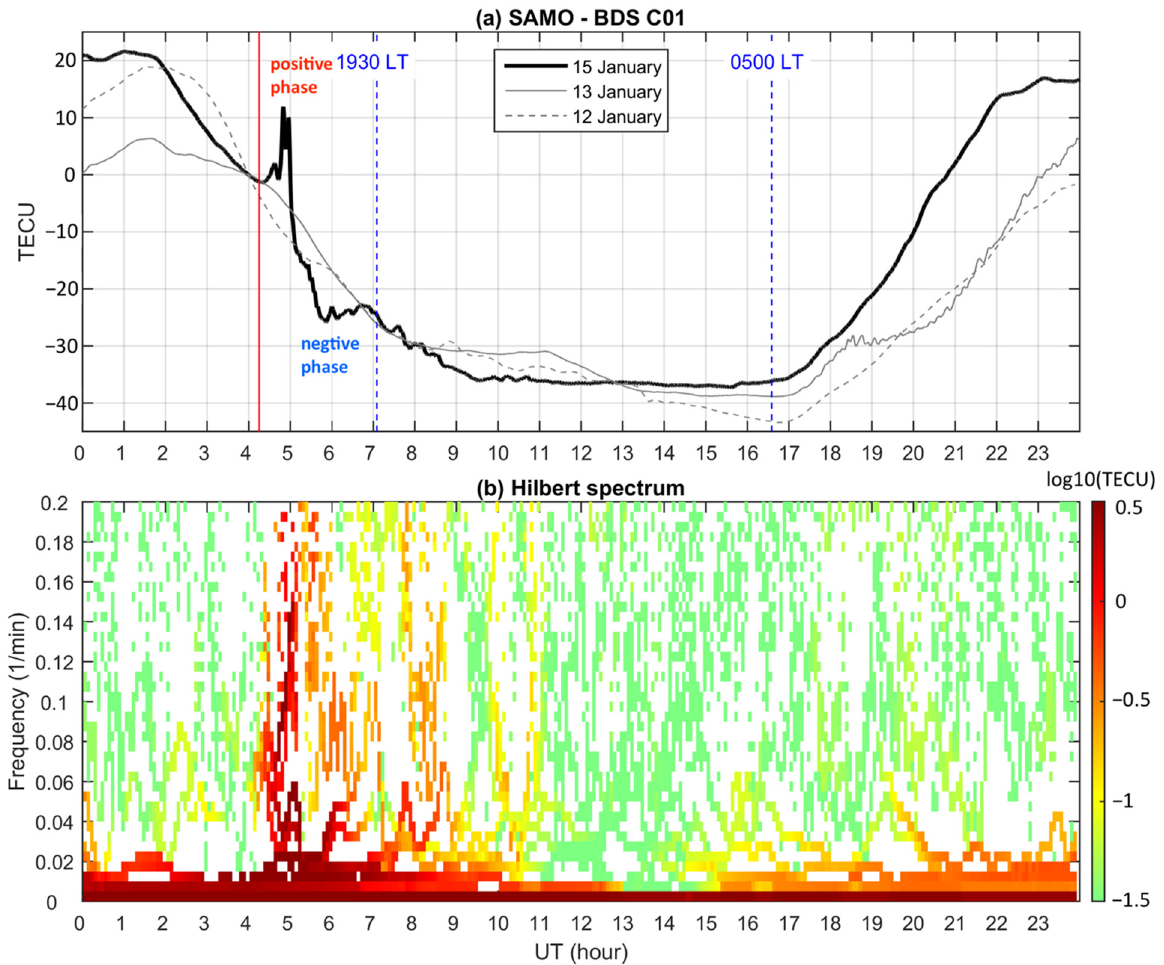
Figure 6. ( a ) The time series of TEC between the receiver SAMO and the BDS C01 on 15 January (black solid line) and the two qiuet days of 13 (gray solid line) and 12 January (gray dash line). The data are unavailable on 14 January. The vertical red line indicates the eruption. The two dash blue lines indicate the sunset and sunrise. ( b ) The corresponding Hilbert spectrum of the TEC time series on 15 January.